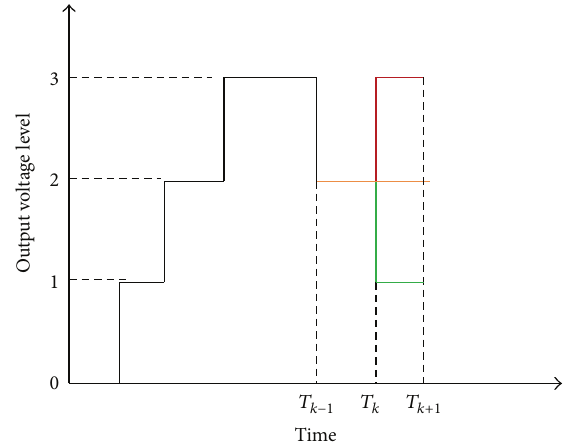
Figure 3: FS-MPC of selecting adjacent levels.